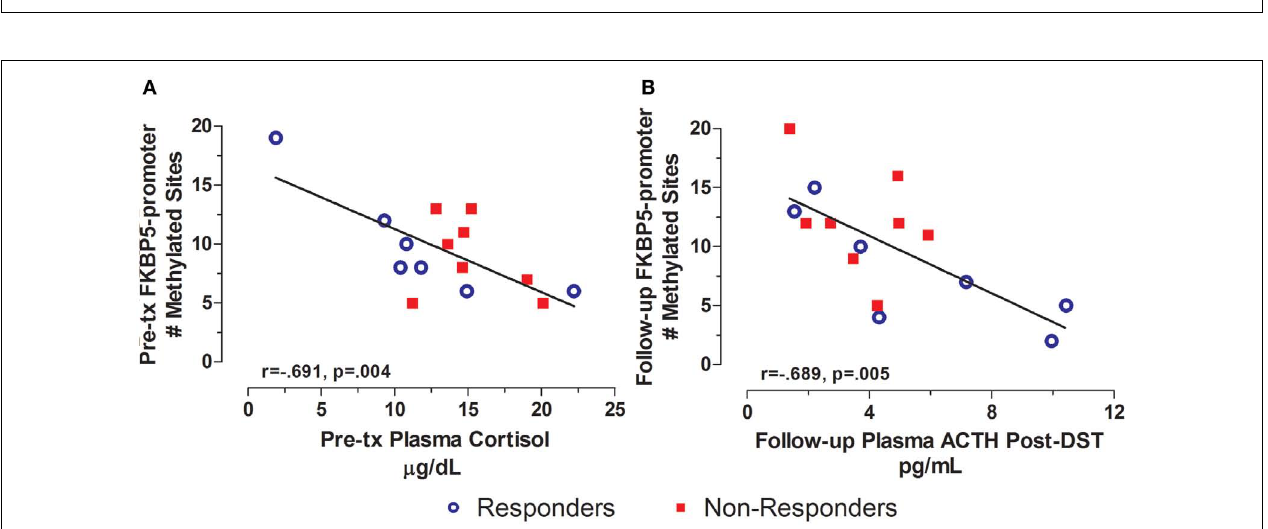
FIGURE 5 | Relationship between GR exon 1F promoter methylation at pre-treatment and urinary cortisol, NPY, and IC50-DEX at post-treatment or follow-up . Correlations of pre-treatment GR exon 1F promoter methylation (# of methylated sites) with adjusted 24h-urinary cortisol (see below) at post-treatment (A) , neuropeptide-Y (NPY) at post-treatment (B) , and IC 50-DEX at follow-up (C) . Responders ( n = 8) to treatment are represented by blue, open circles and non-responders ( n = 8,